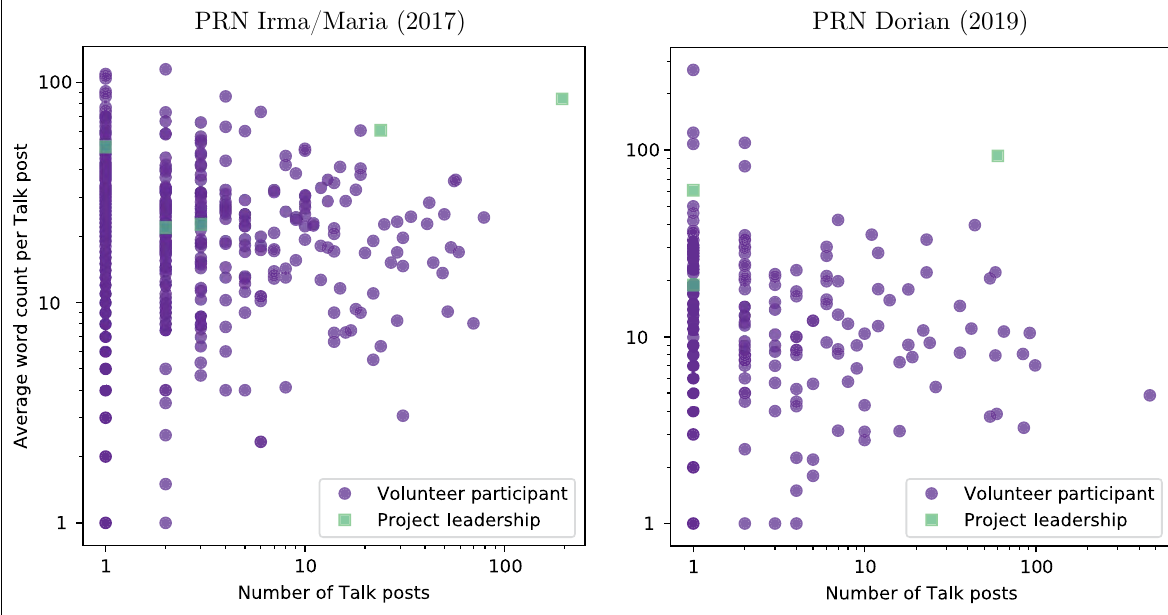
Figure 4 Average length of Talk discussion posts for each participant versus their post count, for Planetary Response Network (PRN) Caribbean deployments. Volunteer participants are shown as purple circles and PRN organizational team members are shown as green